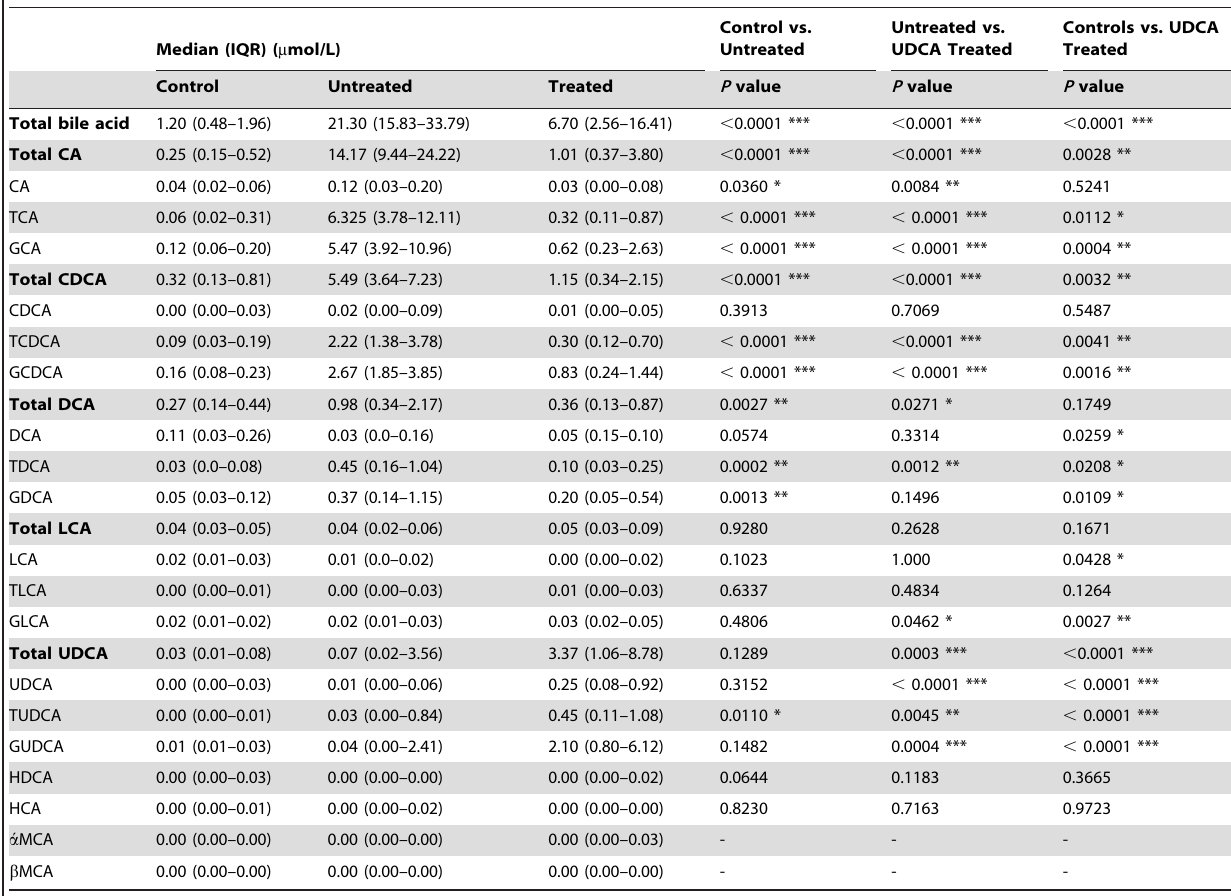
Table 2. Comparisons of bile acid profiles in maternal serum.